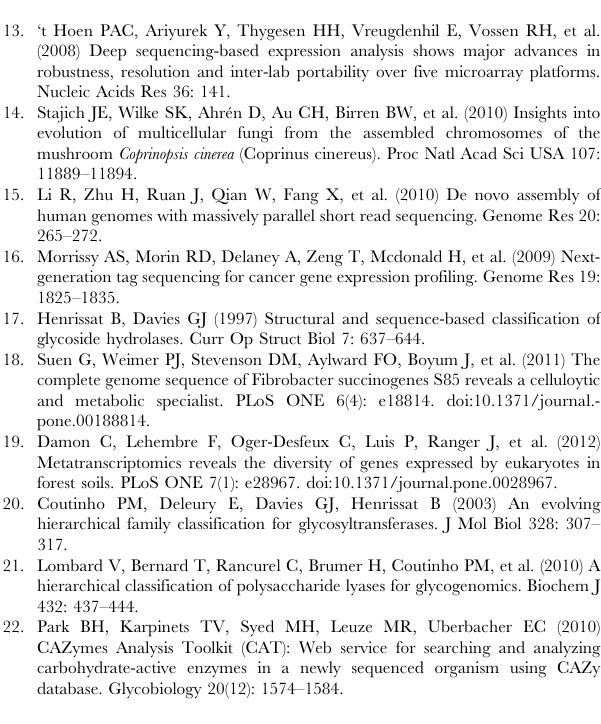
Table S1 The detail of 38 single basidiospores isolates from PY-1. Table S2 285 CAZyme genes in V. volvacea . Table S3 Raw data of the carbohydrate-cleaving fami- lies of 8 basidiomycete genomes. Table S4 Differentially expressed genes between PYd21 and PYd15. Table S5 Differentially expressed genes between H1521 and PYd21.